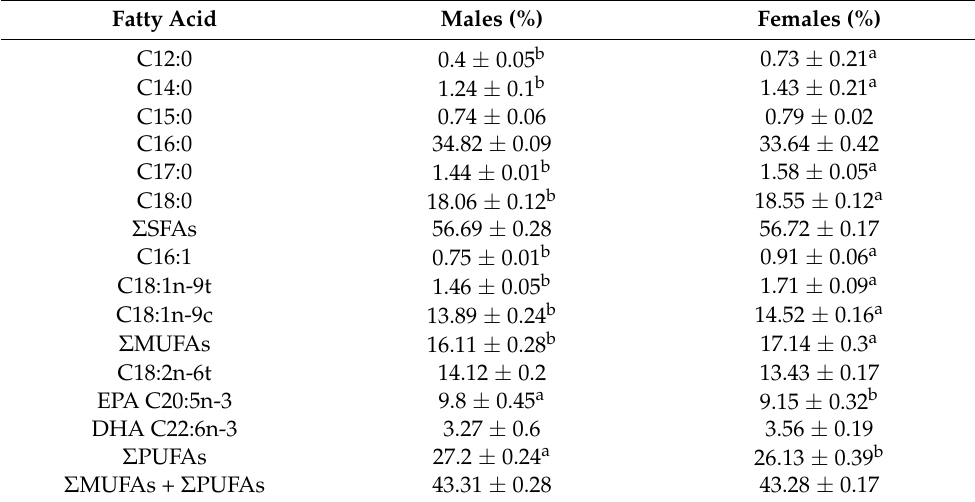
Table 3. Analysis of fatty acids composition in the muscles of C. quadricarinatus with different sexes (dry matter; N =